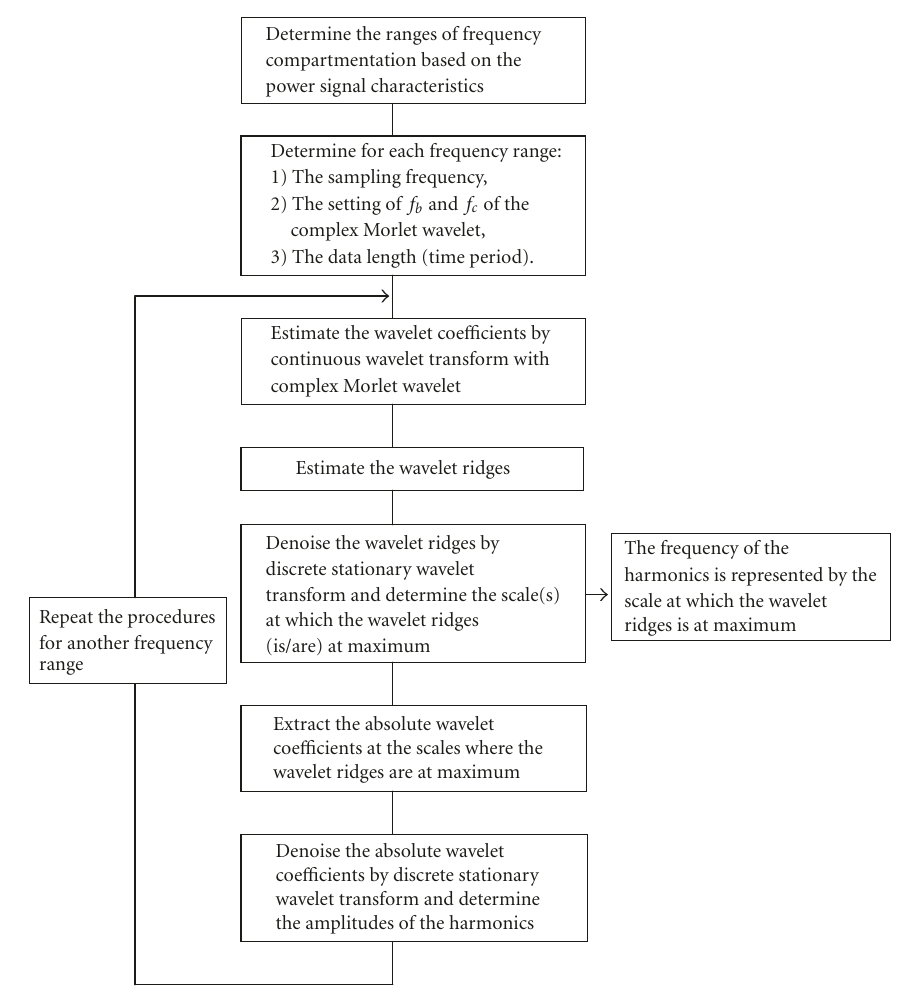
Figure 8: The flow chart of the proposed harmonics detection algorithm.